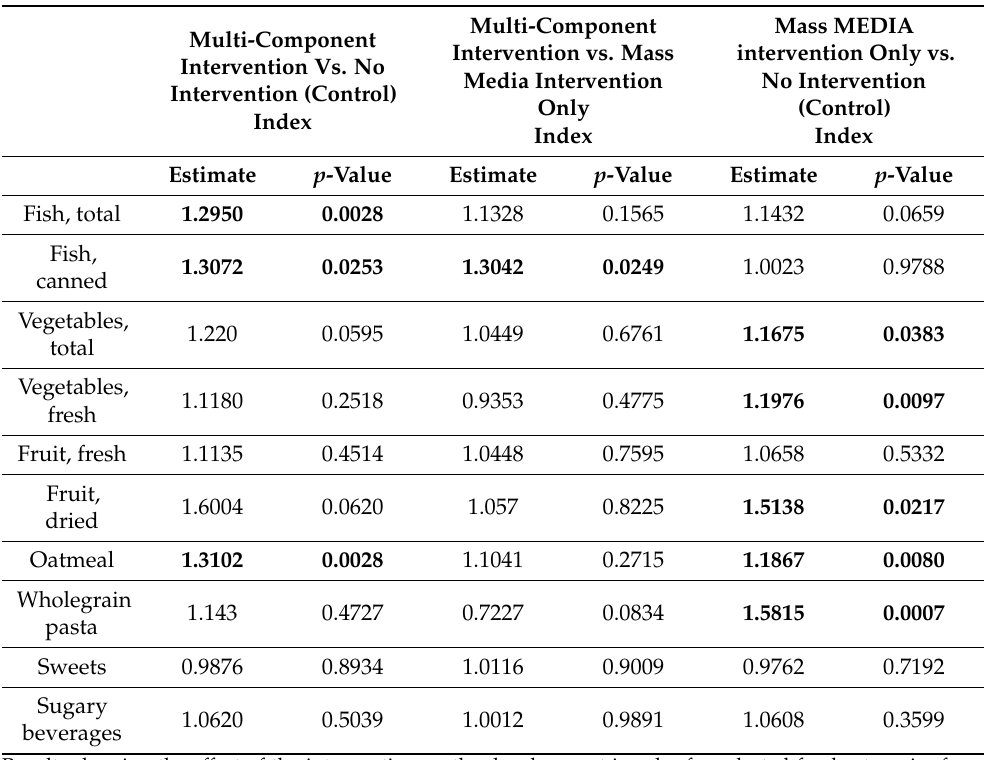
Table 2. Effect of the intervention: comparing the development in the Coop SoL supermarkets (multi- component intervention, level 1), other Coop supermarkets on Bornholm (mass media intervention only, level 2) and Coop supermarkets in the control area (Odsherred municipality, no intervention, level 3). Mass MEDIA Multi-Component Multi-Component intervention Only vs. Intervention vs. Mass Intervention Vs. No No Intervention Media Intervention Intervention (Control) (Control) Only Index Index Index Estimate p -Value Estimate p -Value Estimate p -Value